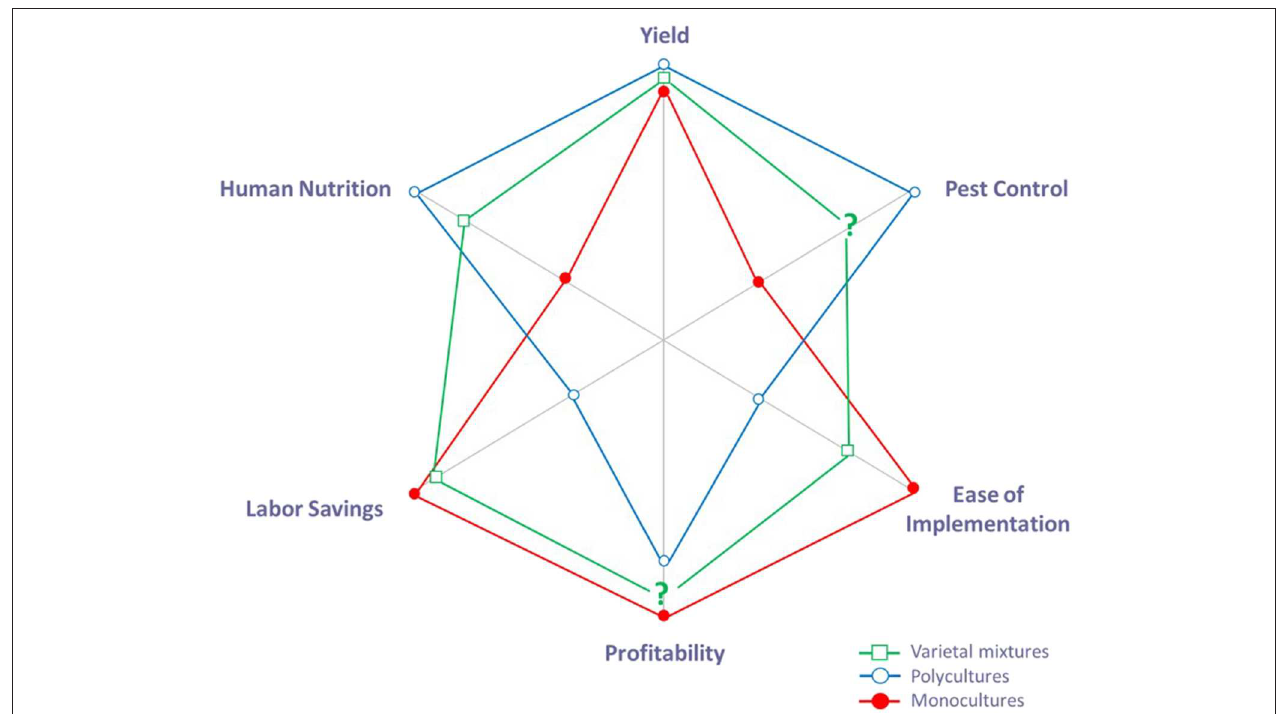
FIGURE 1 | Conceptual framework for comparing the services (human nutrition, yield stability, insect pest control) and economic implications (labor, implementation effort, profits) associated with agricultural management practices. In this qualitative diagram, the level of service or economic implication is indicated along each axis; achieving greater distance along each axis indicates a stronger benefit. To illustrate predictions for how services and economic implications will vary with the level of diversification, we compare three hypothetical agriculture systems: a monoculture, growing a single crop variety in a field (closed circle); a polyculture, intermixing multiple crop species together in a field (open circle); and a varietal mixture, planting multiple varieties of the same crop species together in a field (open square). In general, polycultures enhance many services ( Poveda et al., 2008; Letourneau et al., 2011), but production costs can be high (Gliessman, 1985; Tooker and Frank, 2012 ). In contrast, monocultures minimize costs, but are poor producers of some services (Altieri, 1999; Karp et al., 2012). We propose varietal mixtures could serve as an intermediate strategy that addresses some of the limitations associated with monocultures and polycultures. The symbol “?” represents predictions with the least amount of supporting